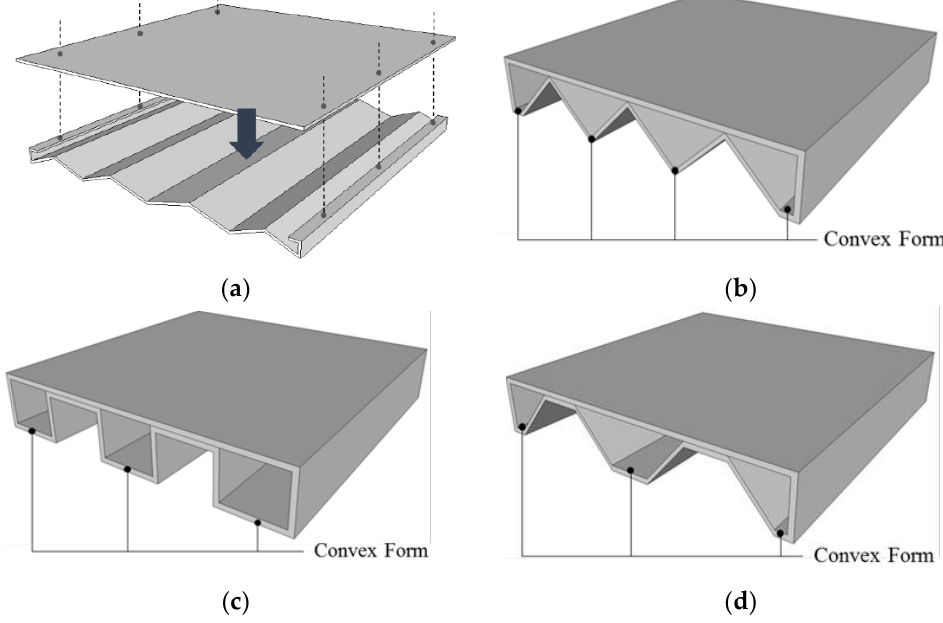
Figure 2. Folded expanded metal mesh (FEMM) diagrams: ( a ) the built-up construction of FEMM; ( b ) the triangular structure of FEMM; ( c ) the rectangular structure with three convex forms of FEMM; and ( d ) the trapezoidal structure with three convex forms of FEMM.